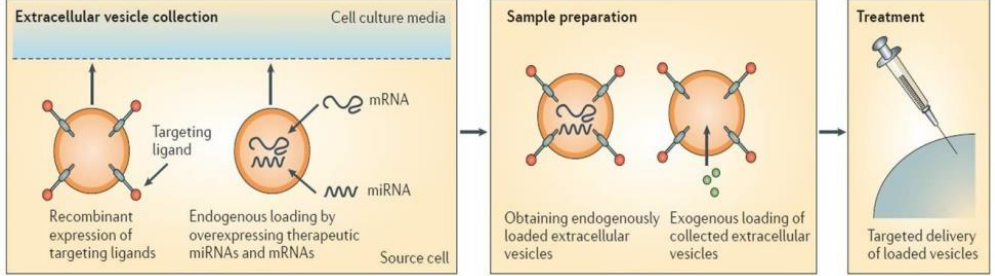
Figure 6. Engineering of extracellular vesicles (EVs). EVs can be engineered to load desired items, which can be carried out either endogenously or exogenously. Endogenous loading is achieved via transfecting parent cells strongly overexpressing miRNA or mRNA; this results in the production of EXOs that are already loaded with the elements of interest upon their collection. Exogenous loading allows the collection of drug-free EXOs which are then loaded with desired cargo molecules either via simple co-incubation with suitable cargo molecules or via active encapsulation with the help of certain procedures, such as electroporation. Modified from Reference [62].